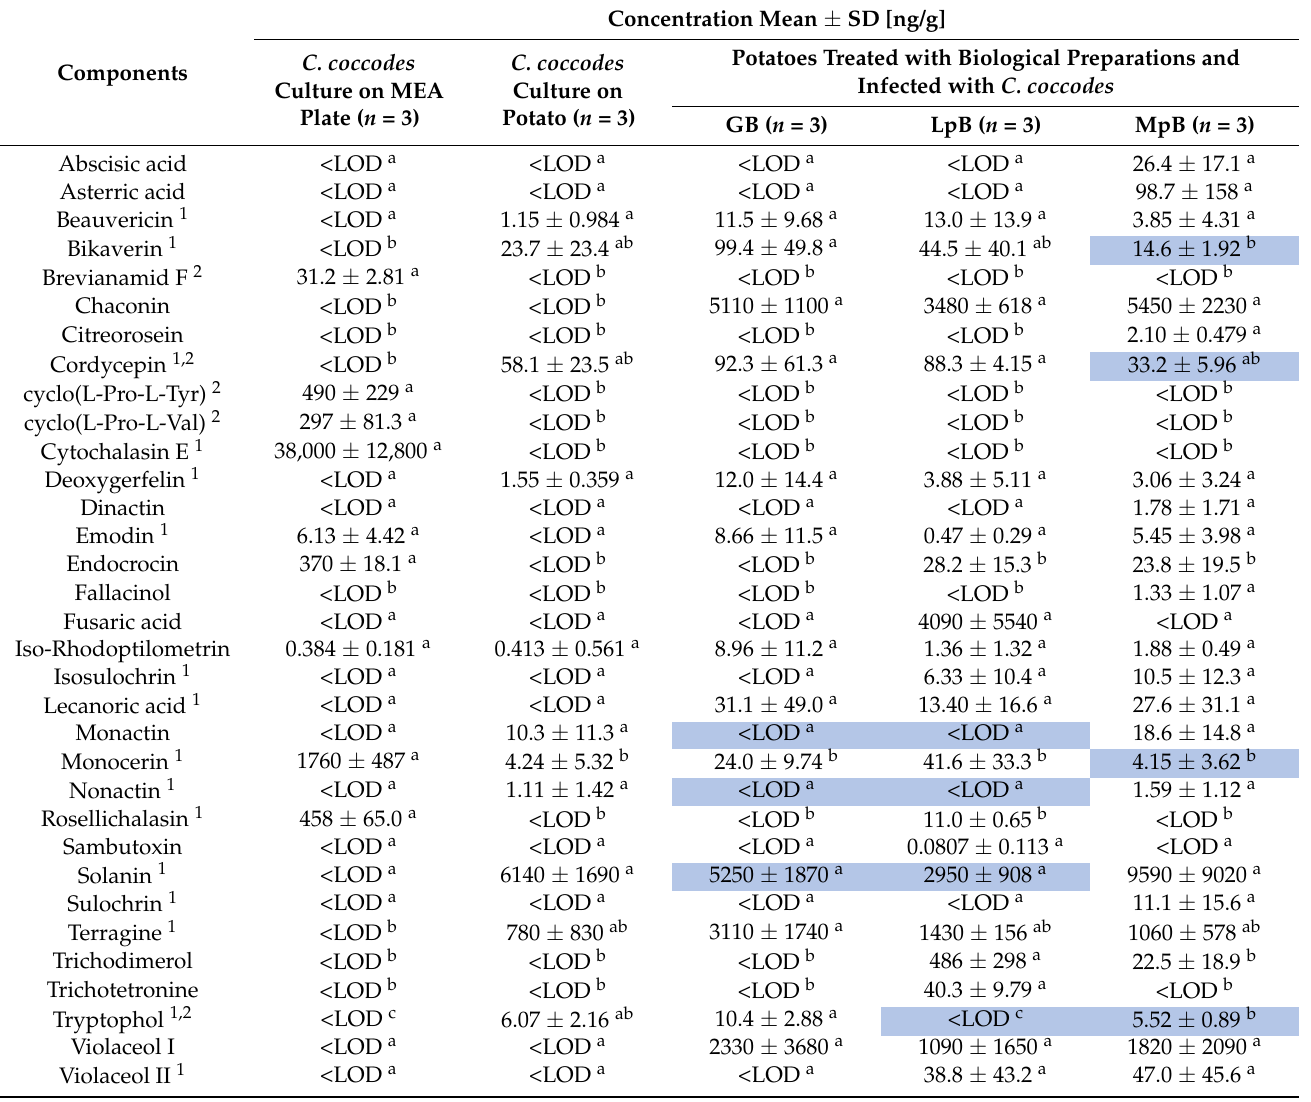
Table 5. Secondary metabolites of Colletotrichum coccodes growing on MEA plates and potatoes treated with